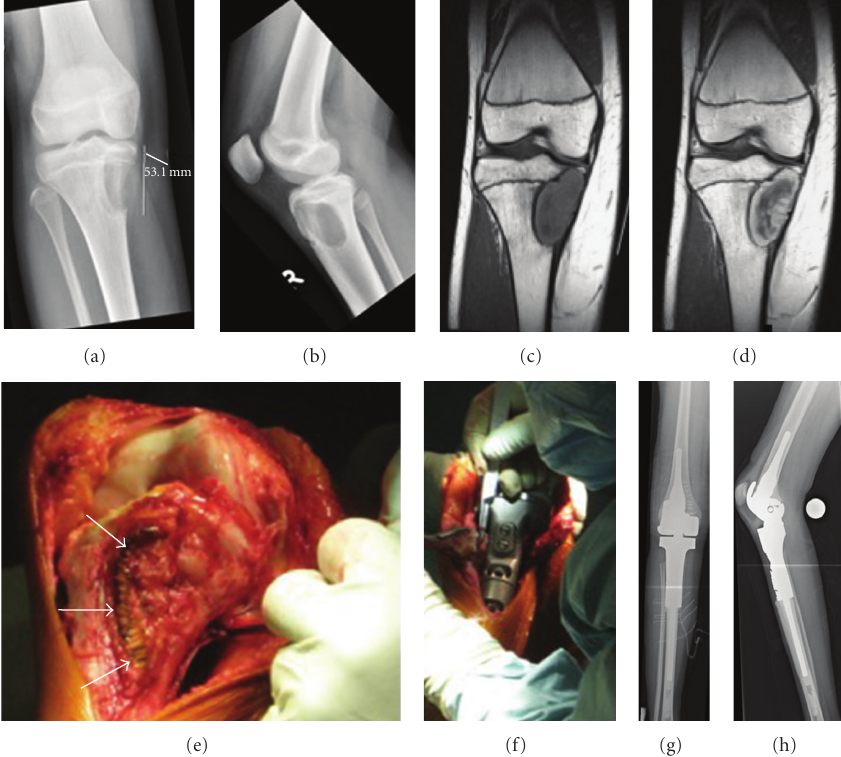
Figure 1: Pre- and postoperative radiological imaging of the right leg and in situ pictures: (a and b) preoperative conventional X-rays of the right knee. The tumor shows an eccentric osteolytic lesion located at the epimetaphyseal proximal tibia, not respecting the epiphyseal plate. The medial cortical bone is completely destroyed and the formation of partially calcified periosteal lining suggests a Lodwick-type 1C lesion. (c) MRI scan demonstrating a T1 isointense, T2 hypointense tumor formation. A similar zonal architecture with a large central core of